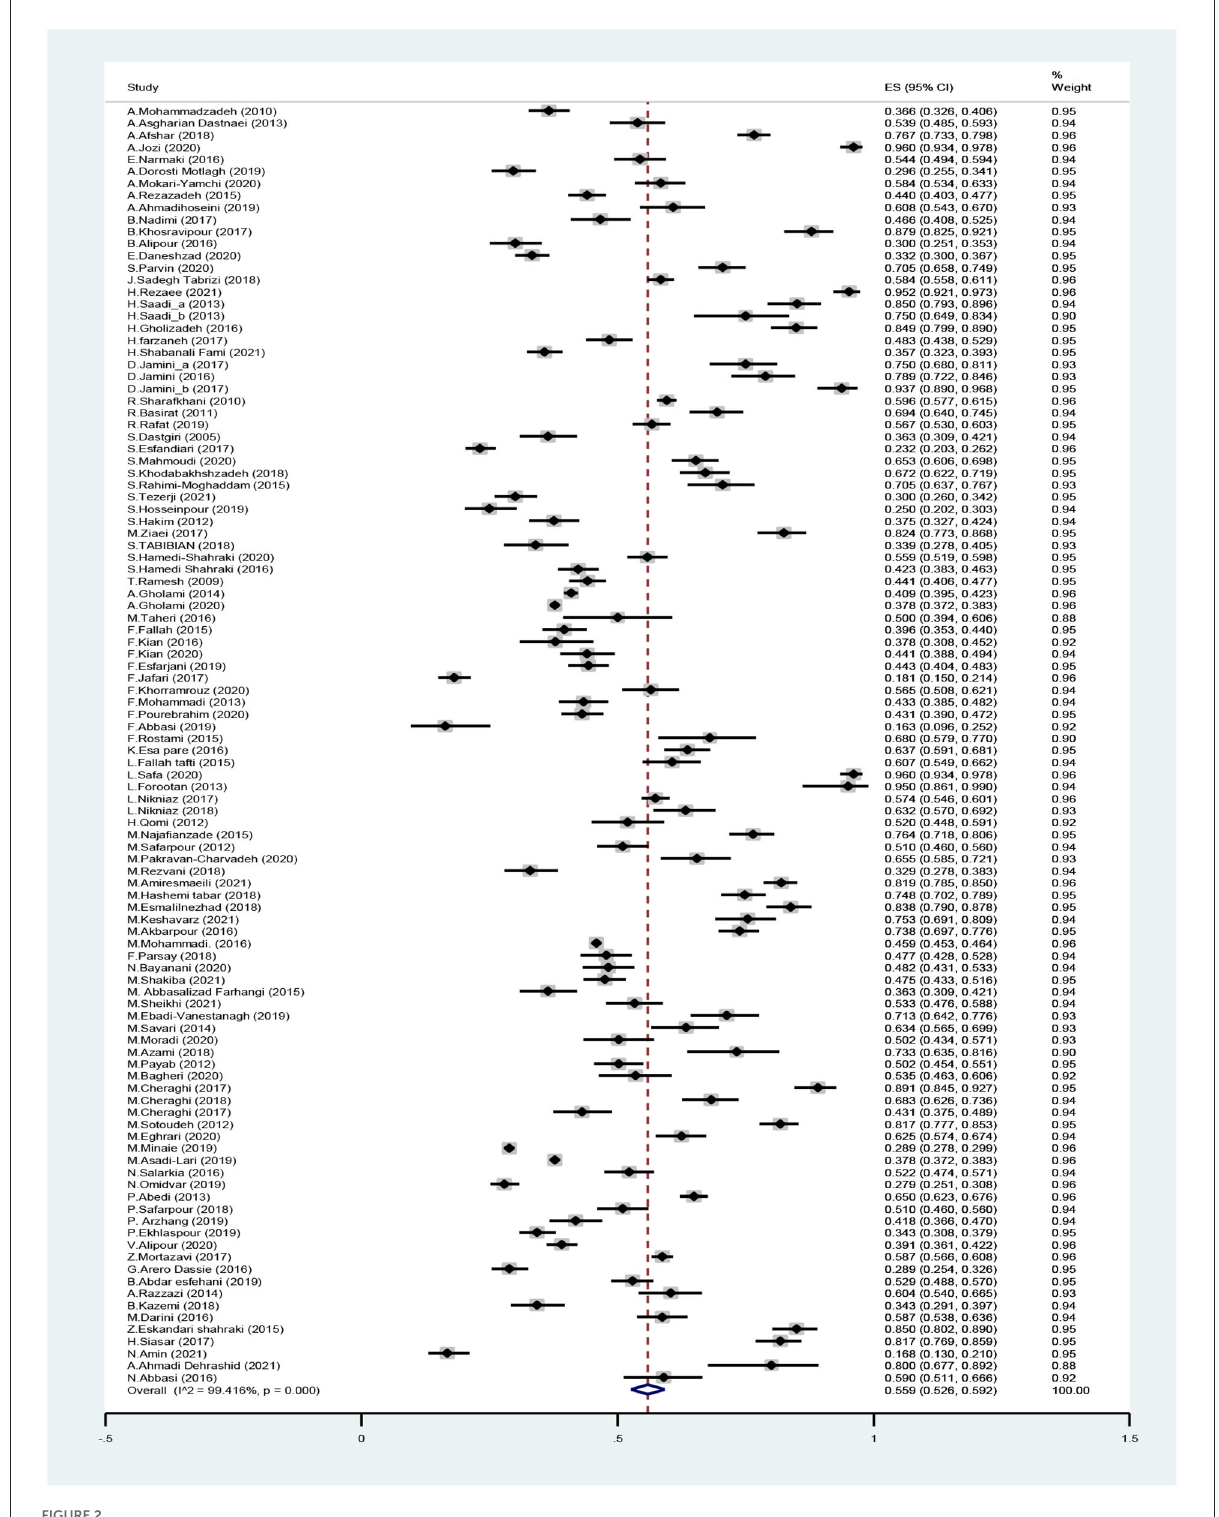
FIGURE2 Forest plot for the prevalence of food insecurity in